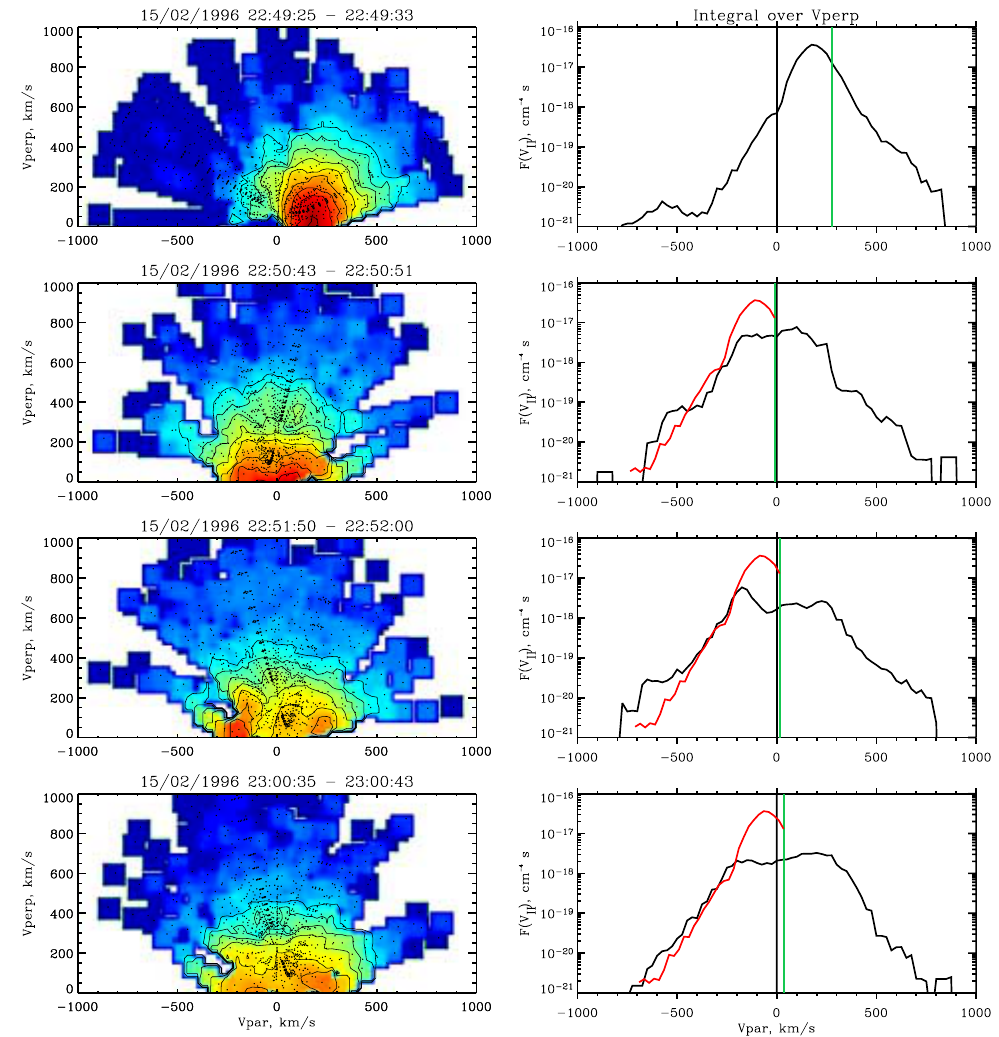
Fig. 11. Magnetosheath velocity distribution is shown as observed before the magnetopause crossing on 15 February 1996 (top). Also shown are three LLBL velocity distributions with high-density, high-speed ion components observed simultaneously, moving along the magnetic field direction and opposite to the magnetic field direction within LLBL interval 3 in Fig. 2. See Fig. 10 for format